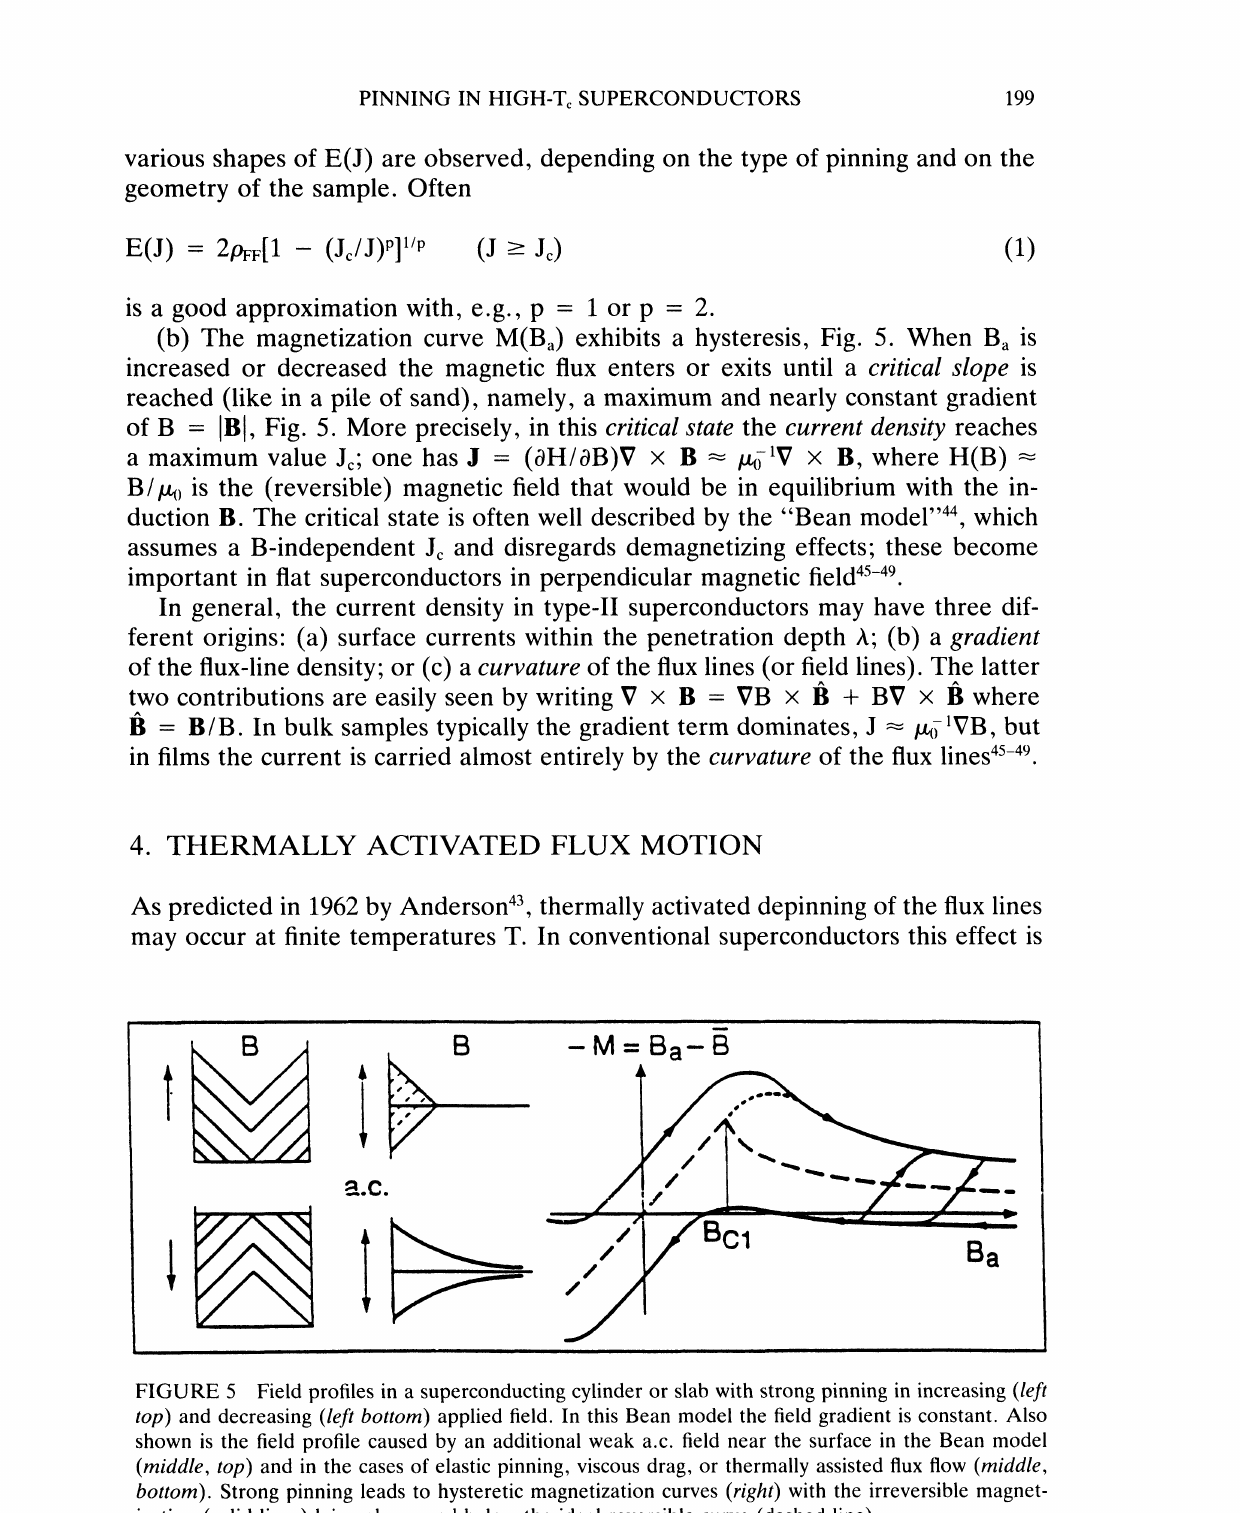
FIGURE 5 Field profiles in a superconducting cylinder or slab with strong pinning in increasing (/eft top) and decreasing (/eft bottom) applied field. In this Bean model the field gradient is constant. Also shown is the field profile caused by an additional weak a.c. field near the surface in the Bean model (middle, top) and in the cases of elastic pinning, viscous drag, or thermally assisted flux flow (middle, bottom). Strong pinning leads to hysteretic magnetization curves (right) with the irreversible magnet- ization (solid lines) lying above and below the ideal reversible curve (dashed